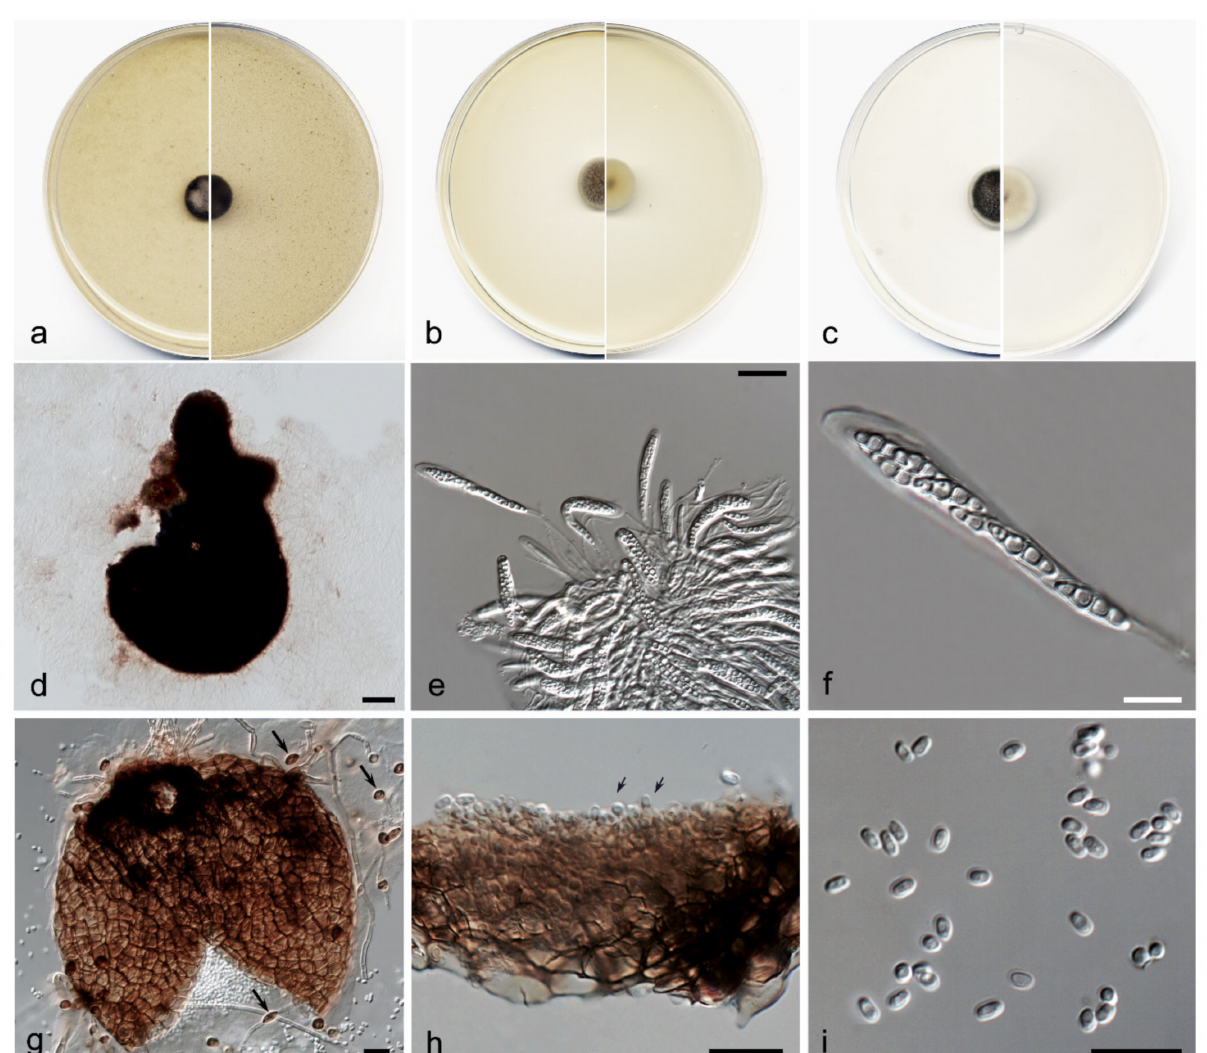
Figure 11. Neovaginatispora aquadulcis FMR 18914. ( a ) Colonies on OA ( b ) MEA ( c ) PDA after two weeks at 25 + 1 ◦ C (surface, left; reverse, right); ( d ) Ascomata; ( e , f ) Asci with ascospores; ( g ) Pycnidium and chlamydospores (black arrows); ( h ) Conidiogenous cells (black arrows); ( i ) Conidia. Scale bars: ( d , g ) = 50 µ m, ( e ) = 25 µ m, ( f , h , i ) = 10 µ